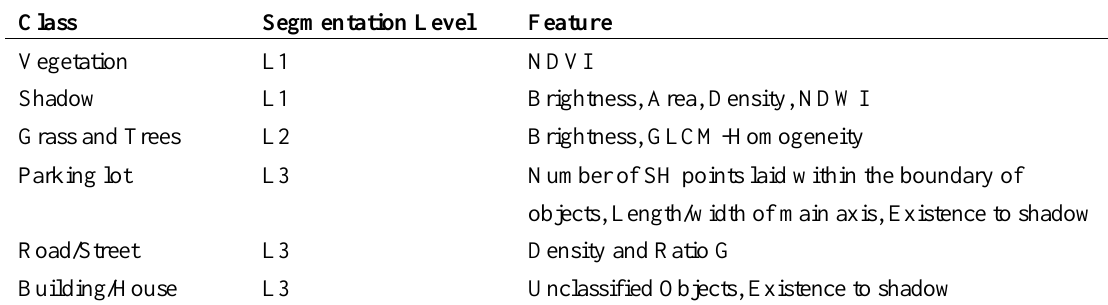
Table 1. Object’s features used in the rule-set hierarchy for different